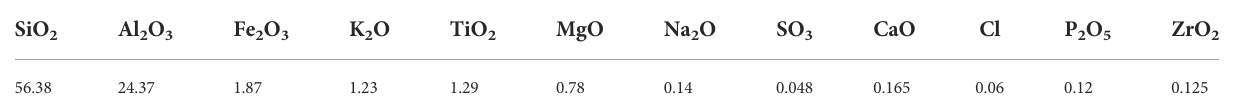
TABLE 1 Elemental analysis of coal gangue